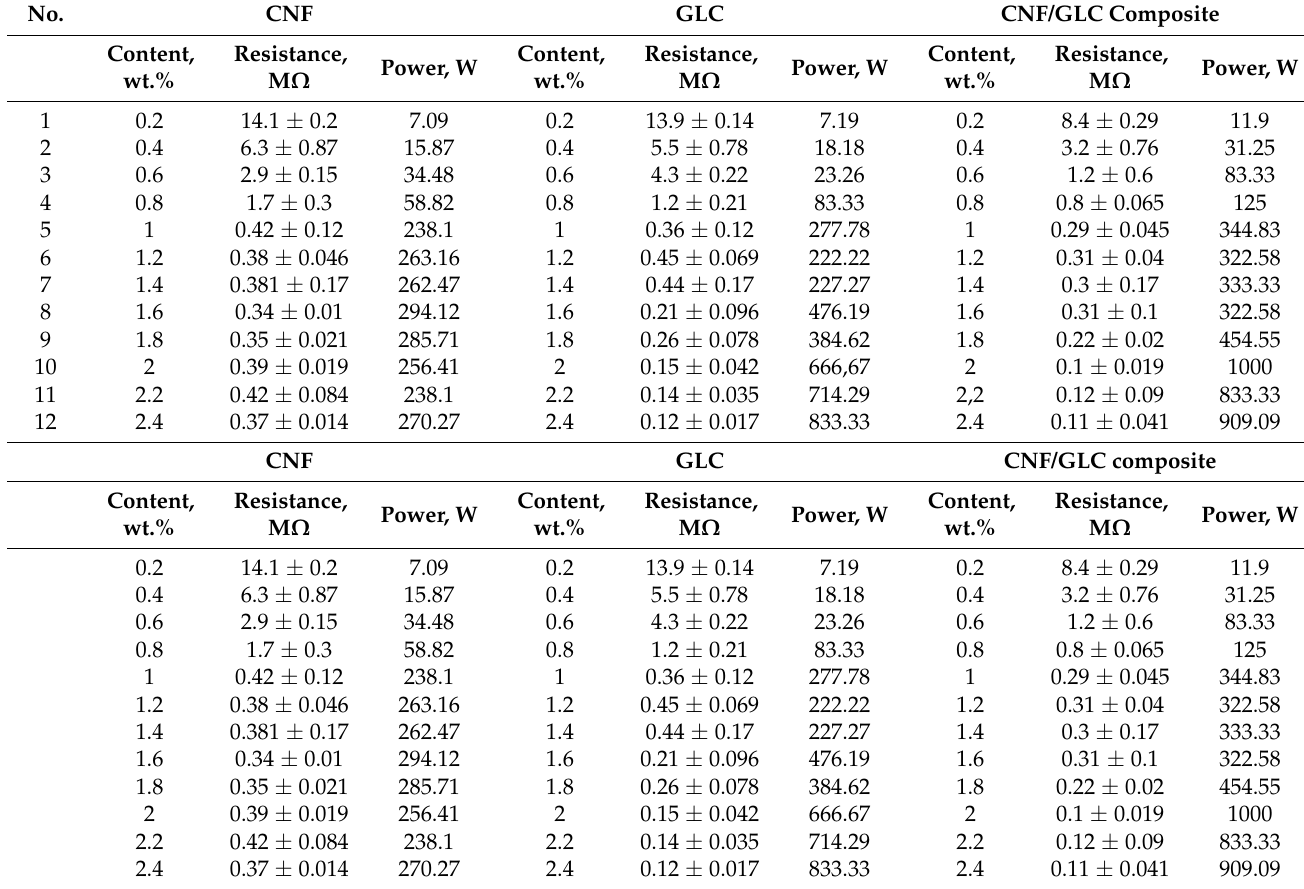
Table 2. Electrical resistance of concrete after addition of carbon nanomaterials